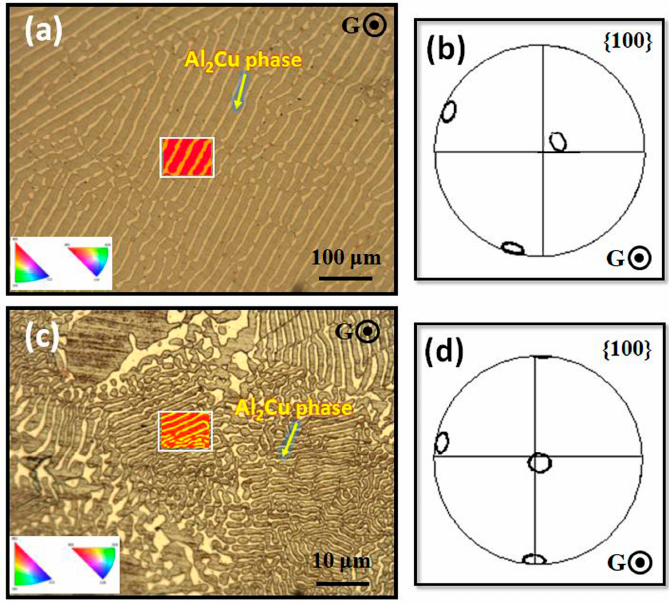
Figure 4. The EBSD analysis of the Al-Al 2 Cu eutectic alloy at the abrupt change in pulling rate from 2 μ m/s to 100 μ m/s. ( a ) the transverse-section microstructure and ( b ) the corresponding (100)-pole figure of eutectic Al 2 Cu phase at 2 μ m/s, respectively; ( c ) the transverse-section microstructure and ( d ) the corresponding (100)-pole figure of eutectic Al 2 Cu phase at 100 μ m/s, respectively.